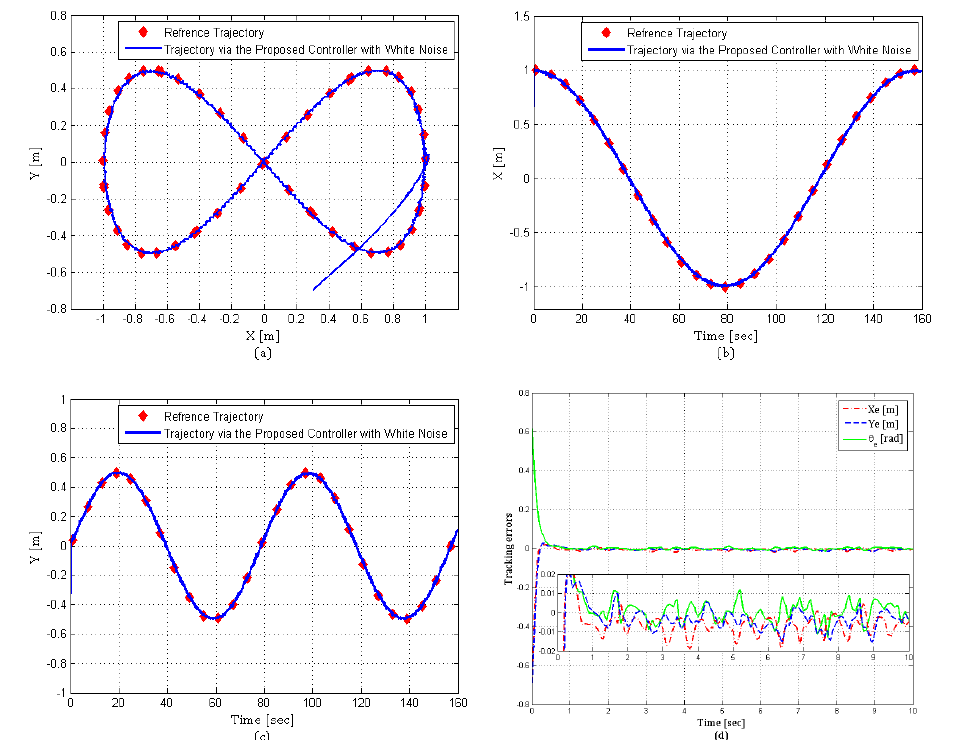
Figure 5. Lemniscate curve trajectory tracking of WMR with white noise. In ( a ) x - y plot. ( b ) Trajectory tracking in x direction. ( c ) Trajectory tracking in y direction. ( d ) Tracking errors ( x e , y e , θ e